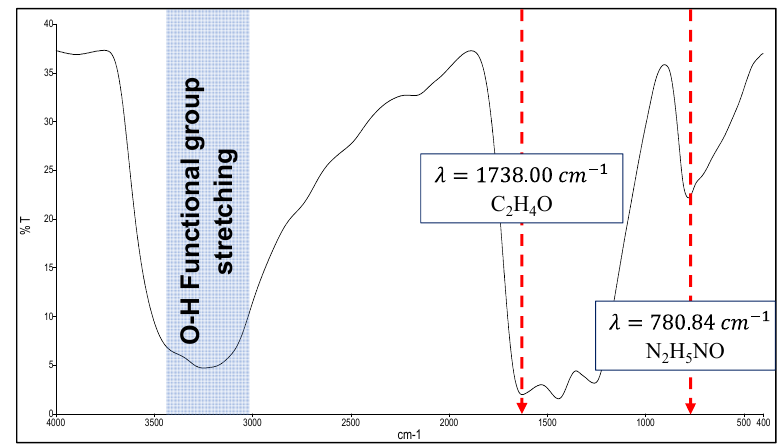
Figure 2. FTIR spectrum of OGCN (oxygenated graphitic carbon nitride) obtained in this study.